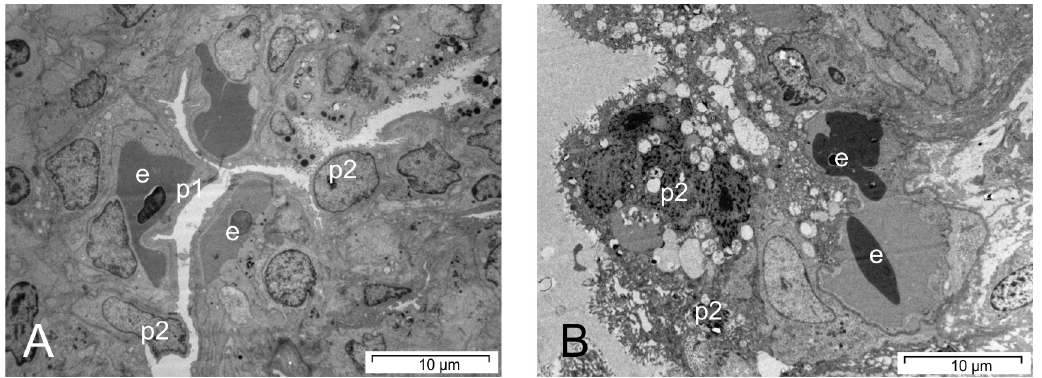
Fig 7. Sections of a lung, transmission electron microscopy of the respiratory epithelium. (A) Score 1, snake No. A12, day 49. Beginning transformation of the lung type-I epithelial cells into type II- pneumocytes. (B) Score 2, snake No. B4, day 16. Complete transformation of the epithelium into a multilayered epithelium consisting of activated type-II pneumocytes. (e–erythrocyte; p1— type-I pneumocyte; p2—type-II pneumocyte).